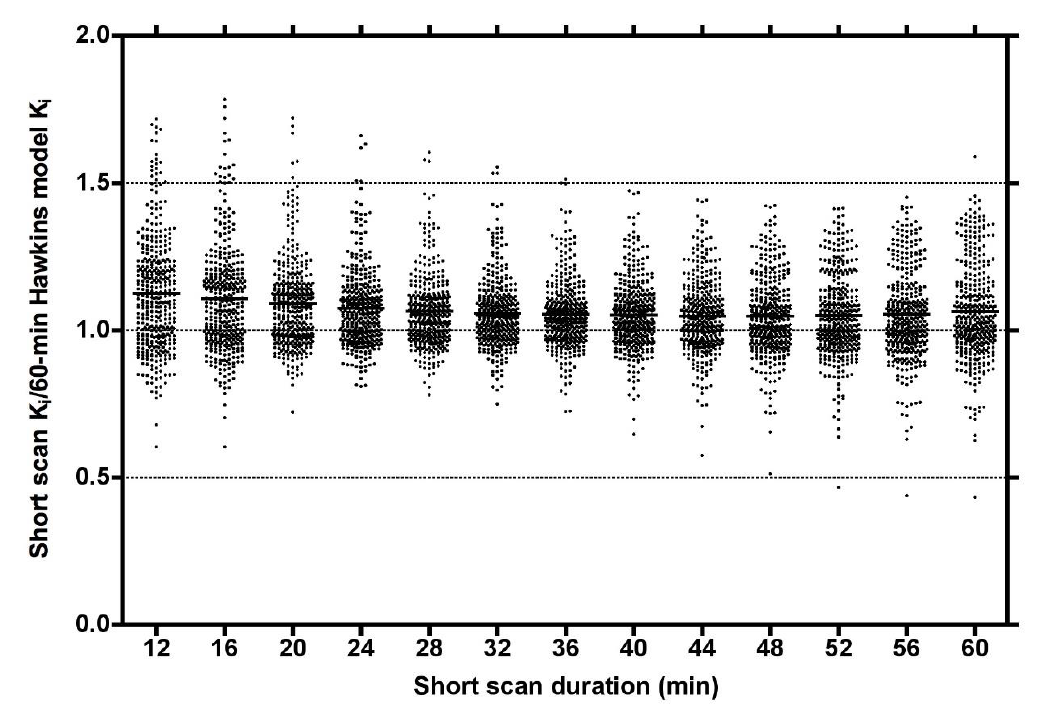
Figure 2. Plot of the ratios of short dynamic scan K i values to the 60-min Hawkins model values for short-scan times between 12 and 60 min incremented in steps of 4 min. Data at each time point are for 54 [ 18 F]NaF PET hip scans (27 baseline and 27 follow-up scans) with 7 volumes of interest analysed for each scan giving a total of 378 data points at each time point.